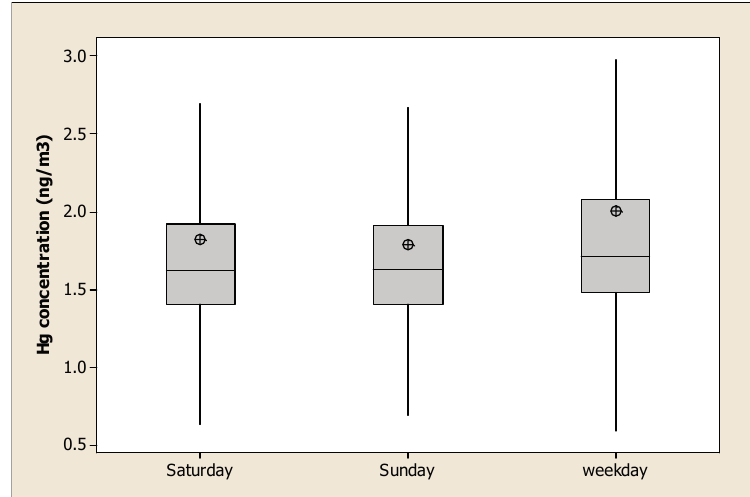
Figure 4. Box plot of day-of-week TGM during 2007–2011 in